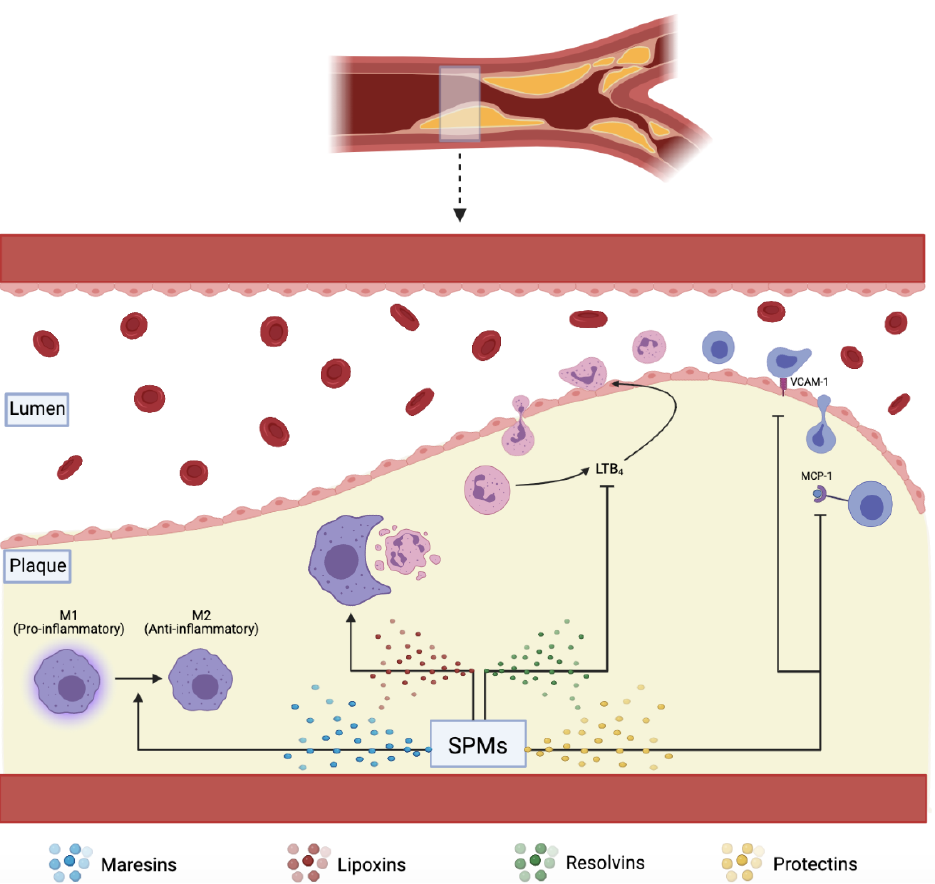
Figure 2. SPMs including maresins, lipoxins, resolvins, and protectins, assist in plaque resolution through various pathways: converting pro-inflammatory M1 to anti-inflammatory M2 macrophages, increasing effective efferocytosis, downregulating pro-inflammatory LTB4, VCAM-1, and MCP-1.